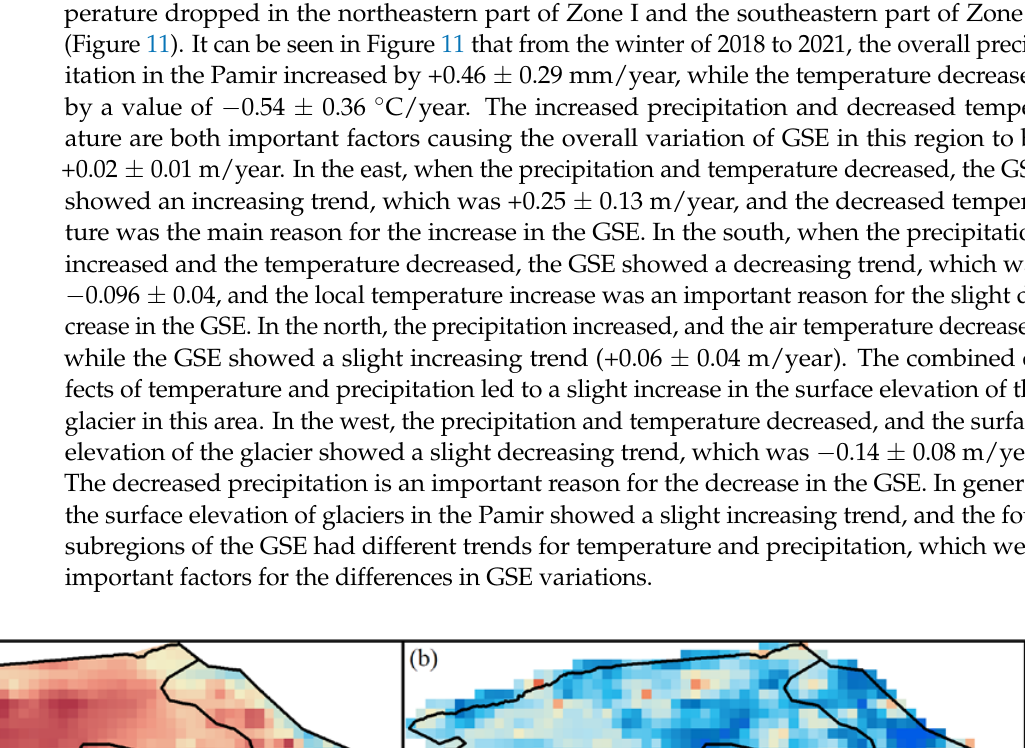
Table 4. Comparison of research results on the different glacier variation trends in Pamir. Gardner et al.